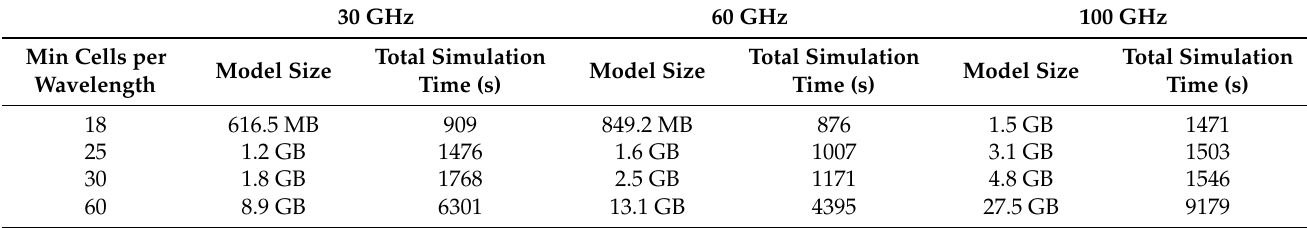
Table 4. The exponential growth of model size and computation time with reducing mesh cell size (cell sizes were specified in PrOGrid